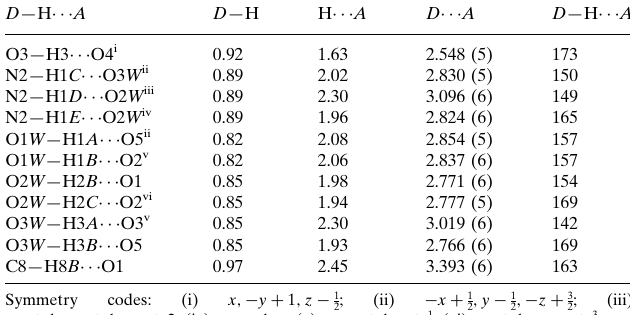
Hydrogen-bond geometry (A˚ , (cid:3)